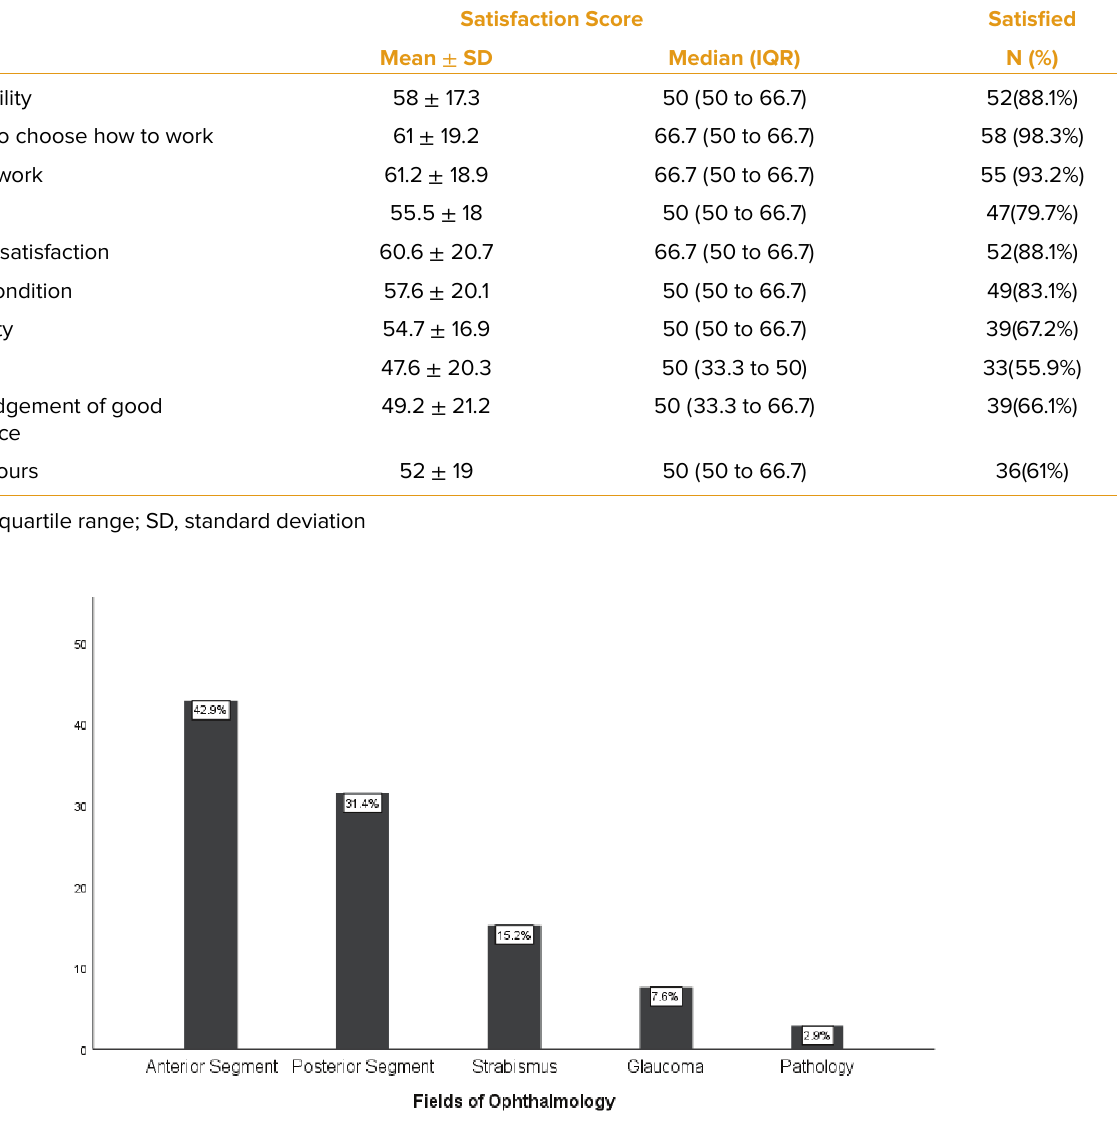
Figure 1. The frequency of job satisfaction in different fields of